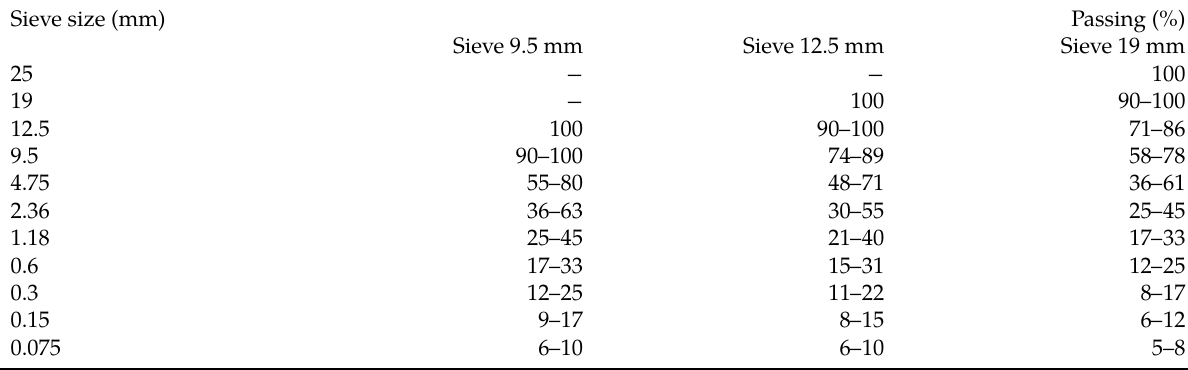
Table 1: Aggregate gradations according to Vietnam standard TCVN 8819:2011 [6].